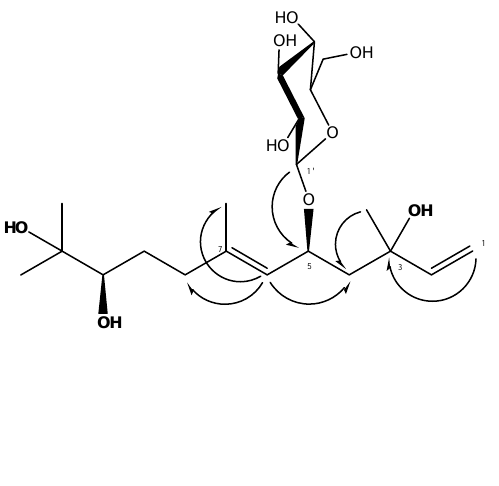
Figure 2. Important HMBC (H → C) correlations of 6